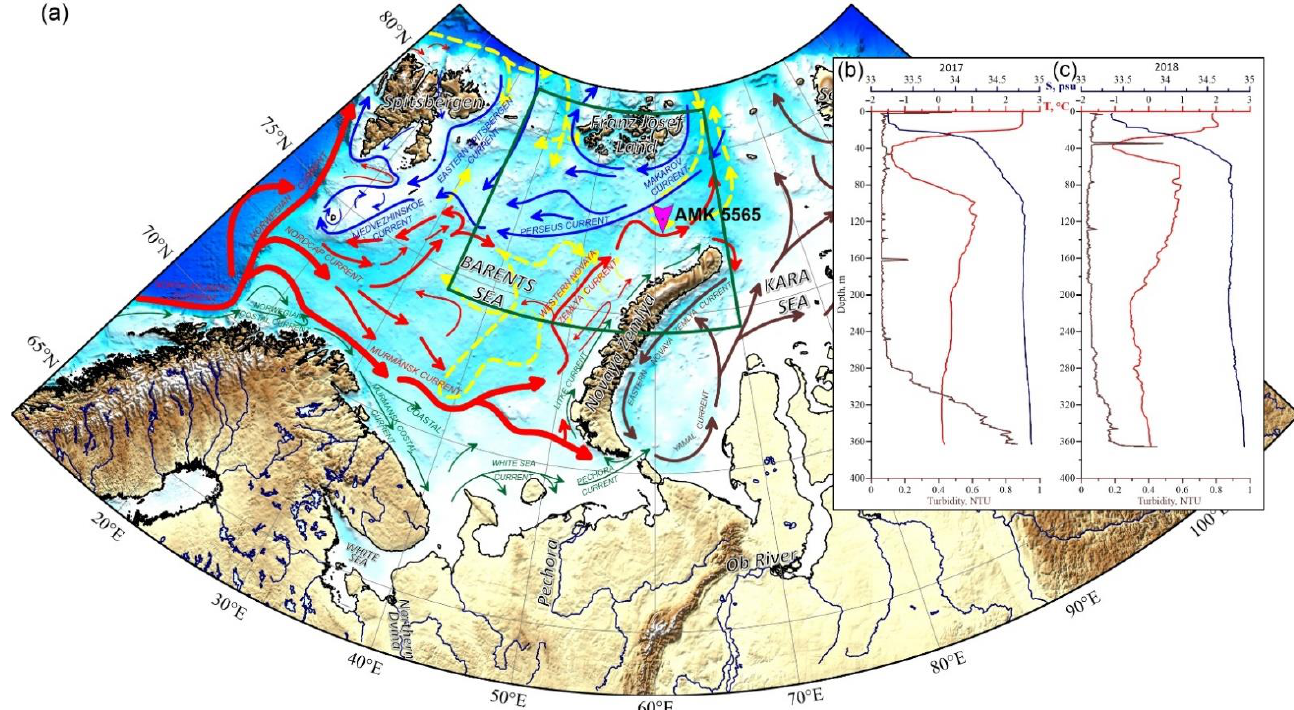
Figure 1. Location of the mooring — Automatic Deep-Sea Sedimentary Observatory (station AMK- 5565) and general directions of currents: ( a ) Red arrows — warm currents; blue arrows — cold currents, green arrows — coastal currents, yellow dashed arrows — subsurface (>100 m) currents, brown arrows — general circulation in the Kara Sea after [4,14,15]. Vertical profiles of temperature, salinity and turbidity before the deployment ( b ) and after the retrieval ( c ) of the ADOS. Green frame shows the position of Figure 2.